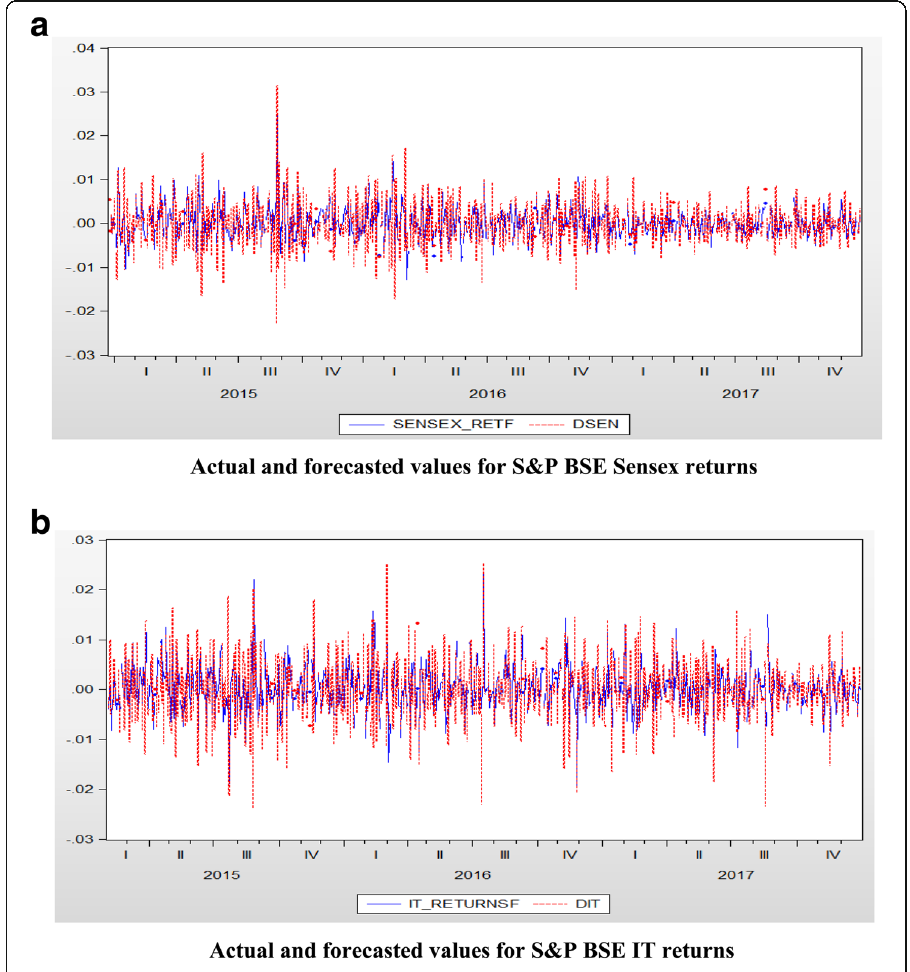
Fig. 4 a Actual and forecasted values for S&P BSE Sensex returns. b Actual and forecasted values for